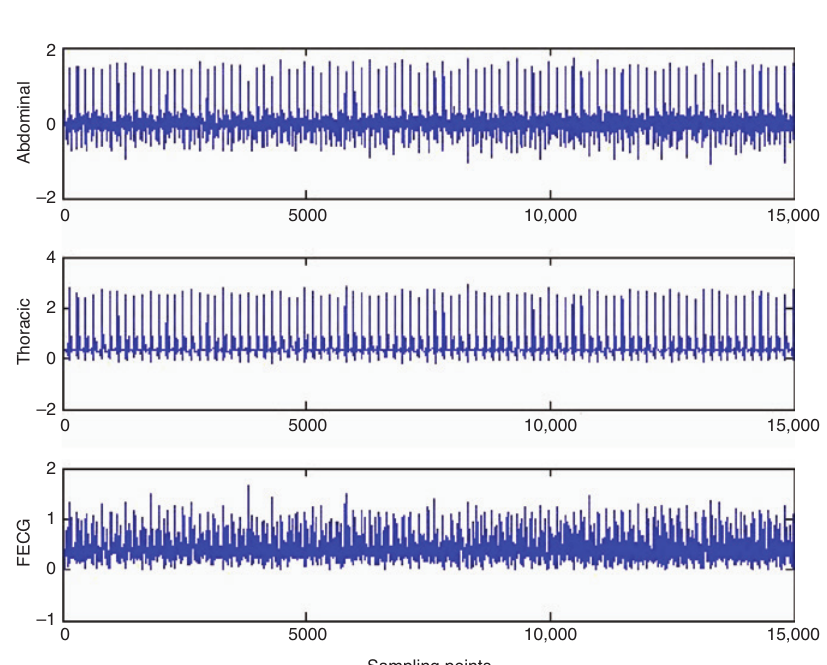
Figure 6: fECG Extraction for Sample Input 1.